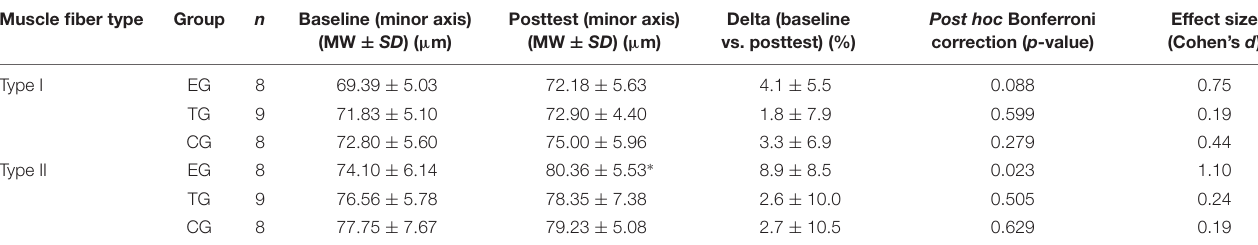
TABLE 3 | Results for myofiber diameter (minor axis) in Type I and Type II fibers in EMS-Group (EG), Training-Group (TG), and Control-Group (CG) 2 weeks before (Baseline) and after intervention period (Posttest). Muscle fiber